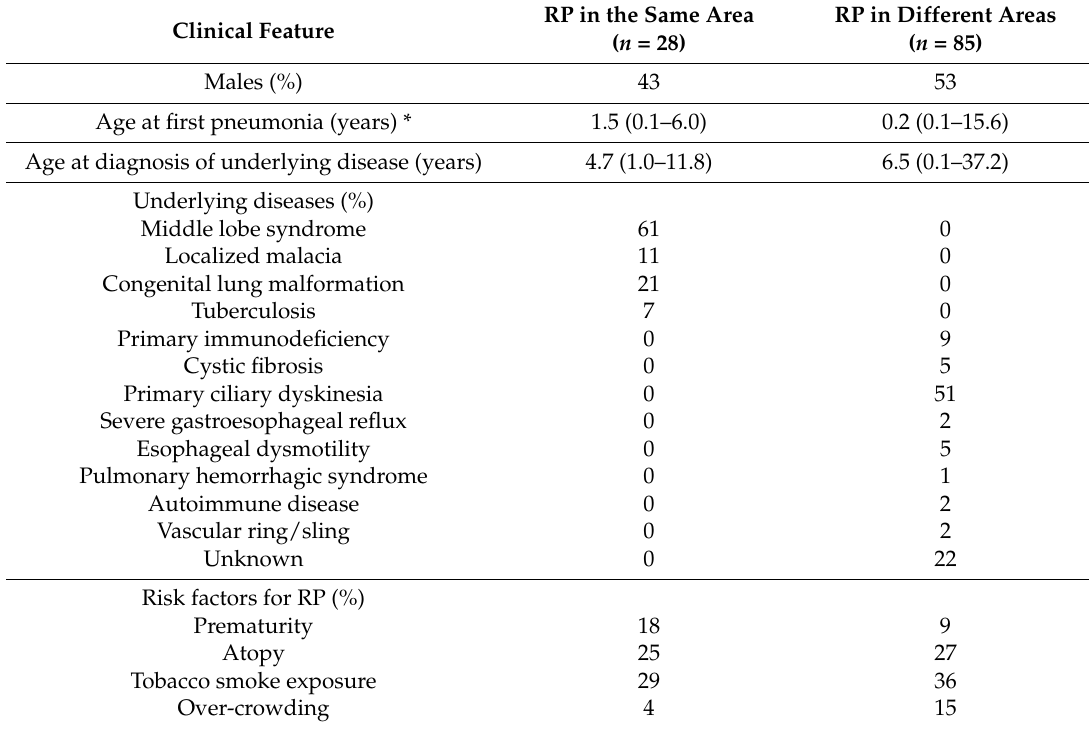
Table 5. Characteristics of 113 children with radiologically confirmed recurrent pneumonia from a university hospital in Italy.